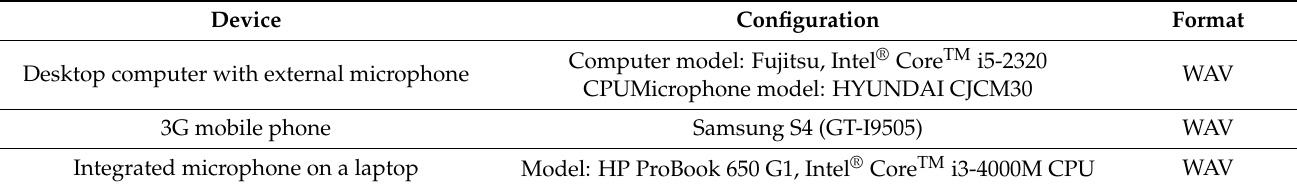
Table 1. Recording device